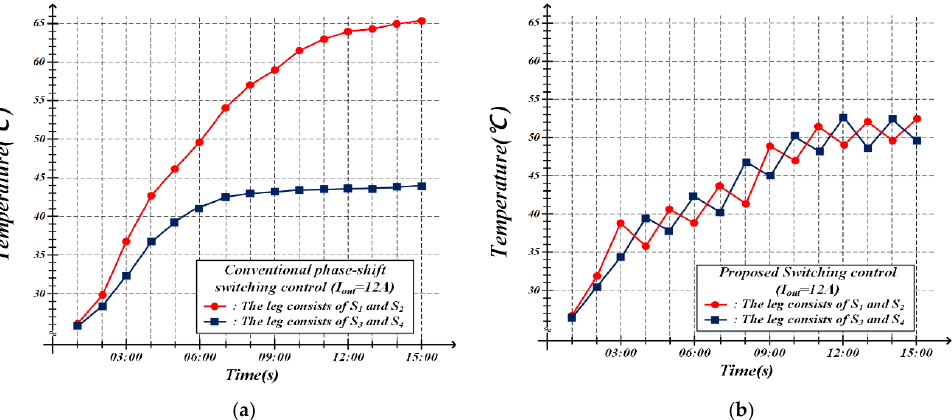
Figure 13. Temperature measurement of the PSFB converter. ( a ) Conventional phase-shift switching control. ( b ) Proposed switching control.